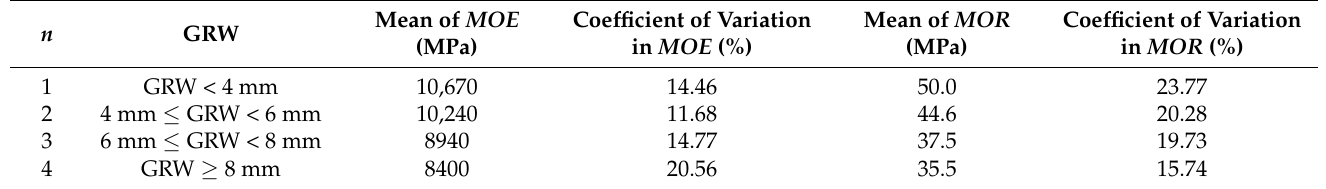
Table 1. Effect of GRW on MOE and MOR of Chinese fir